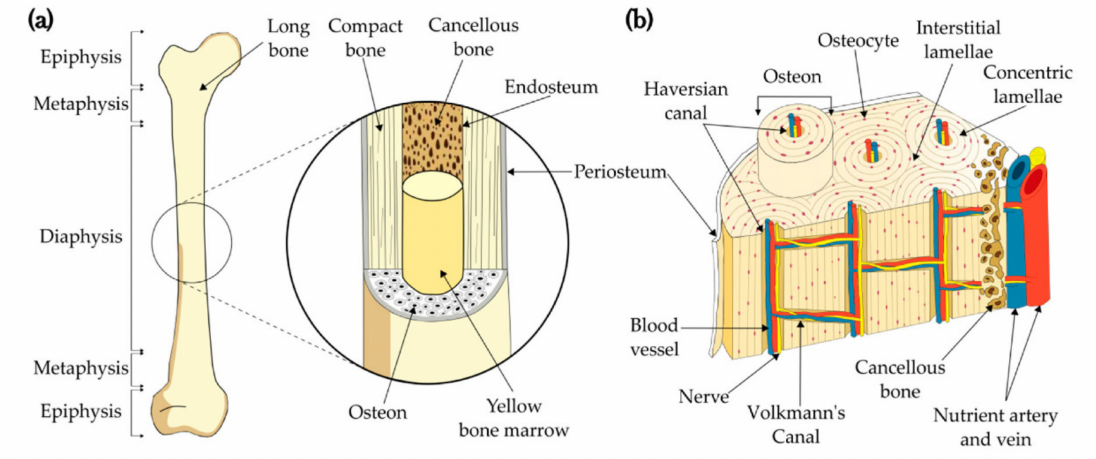
Figure 1. Bone structure: ( a ) long bone and ( b ) microstructure